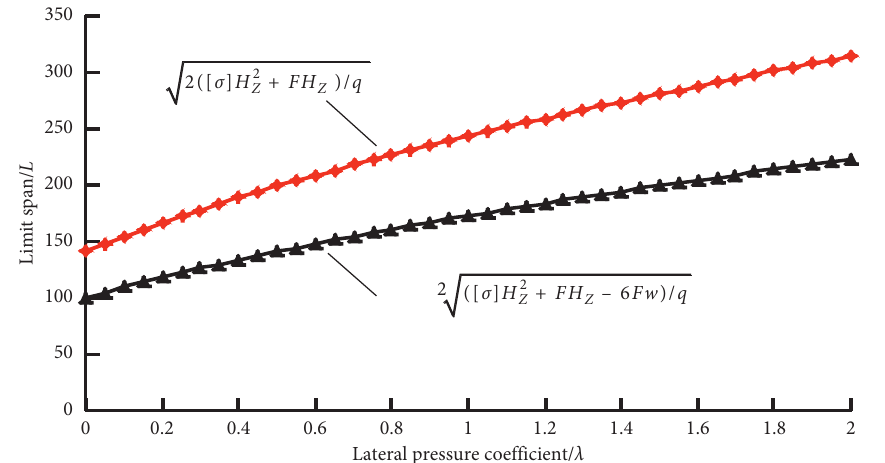
Figure 11: Different lateral pressure coefficients and limestone limit